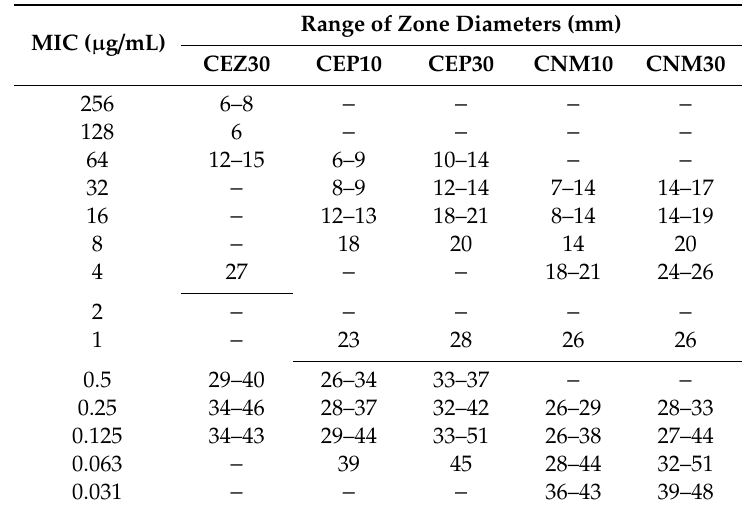
Table 2. The range of ZDs of CEZ30, CEP10, CEP30, CNM10, and CNM30 disks by MICs of the corresponding drug for 130 S. aureus isolates from bovine